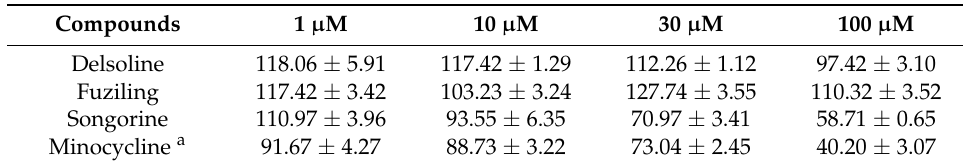
Table 2. Inhibition rate (%) of 4 compounds at different concentrations on NO production by LPS-activated N9 cells (Mean ± SEM).